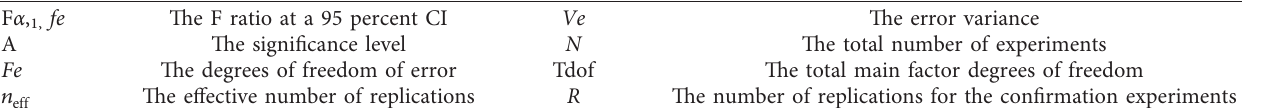
Figure 7: Comparison of actual and estimated values for Fc. Table 7: Representations of the expressions in equations (8) and (9).